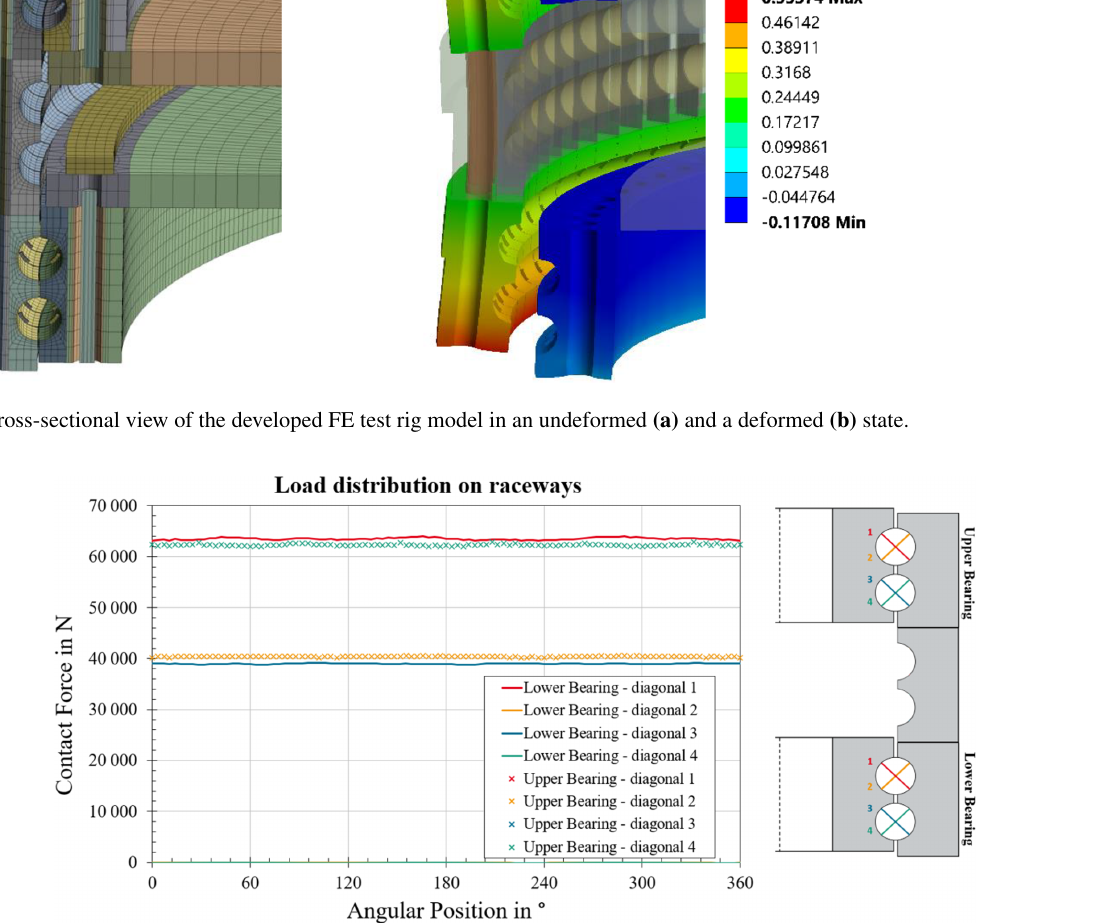
Figure 3. Resulting load distribution on the raceways of both test bearings for 8.0MN total axial